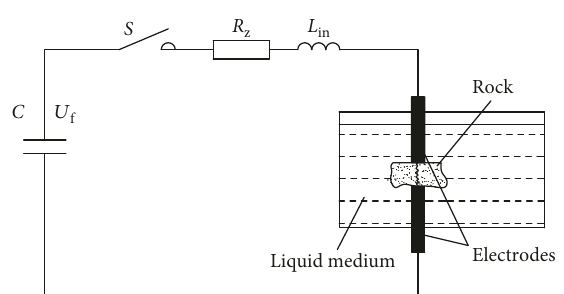
Figure 5: Equivalent circuit of high-voltage pulsed granite breaking: C � total equivalent capacitance; S � discharge switch; R z � circuit resistance; L in � inductive inductance; and R td � plasma channel